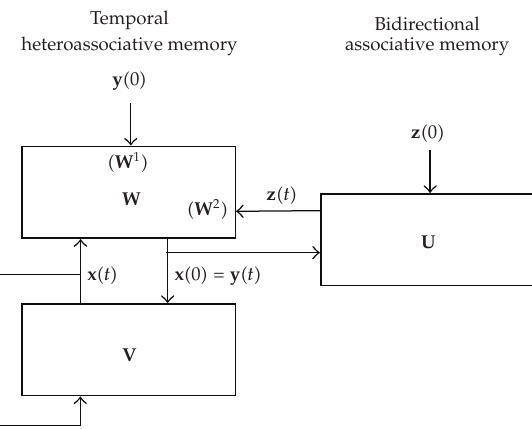
Figure 18: Architecture of the multidirectional associative memory. The network is composed of a temporal heteroassociative memory and a bidirectional associative memory.